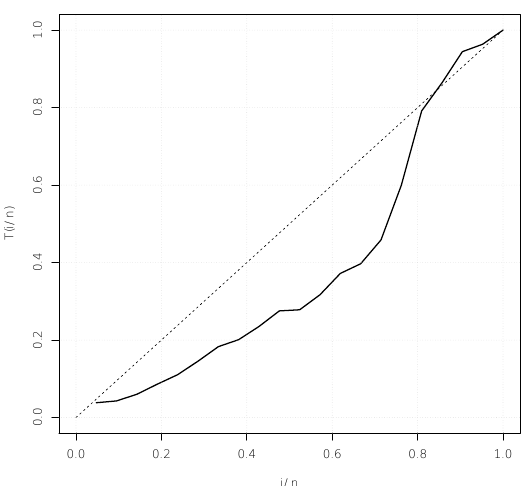
Figure 6 - Gaussian kernel density estimation for the data of the time between failures (thousands of hours) of secondary reactor